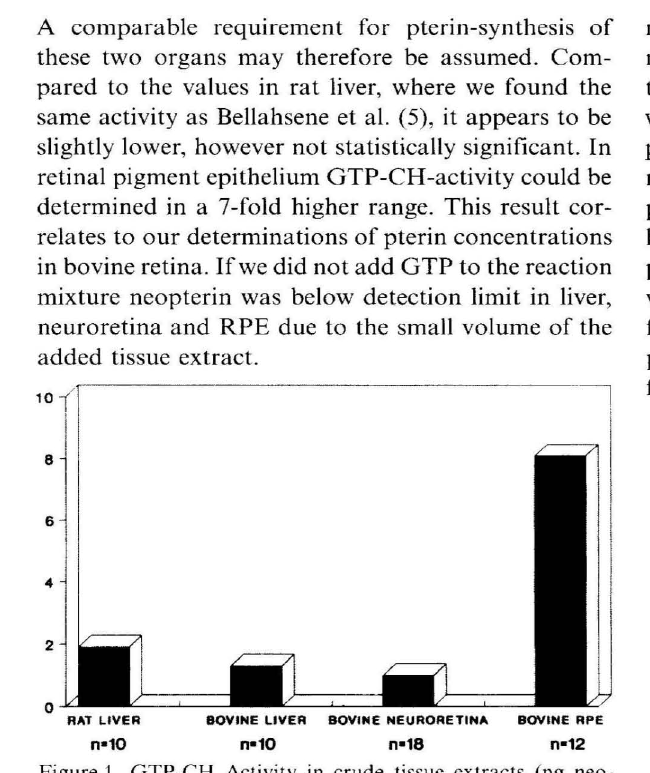
Figure 1. GTP-CH Activity in crude tissuc cxtracts (ng nco pterin/30 min/mg protcin) The neuroretina contains high pterin-concentrations